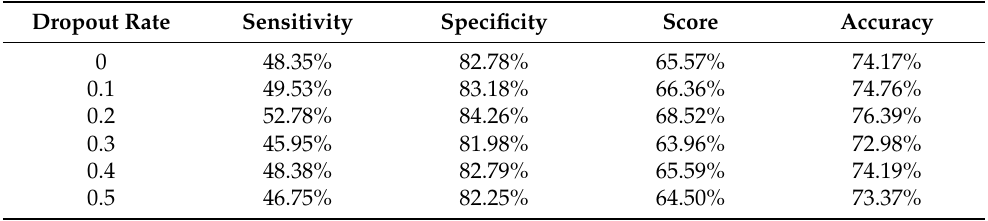
Table 2. Proposed model’s performance for different dropout